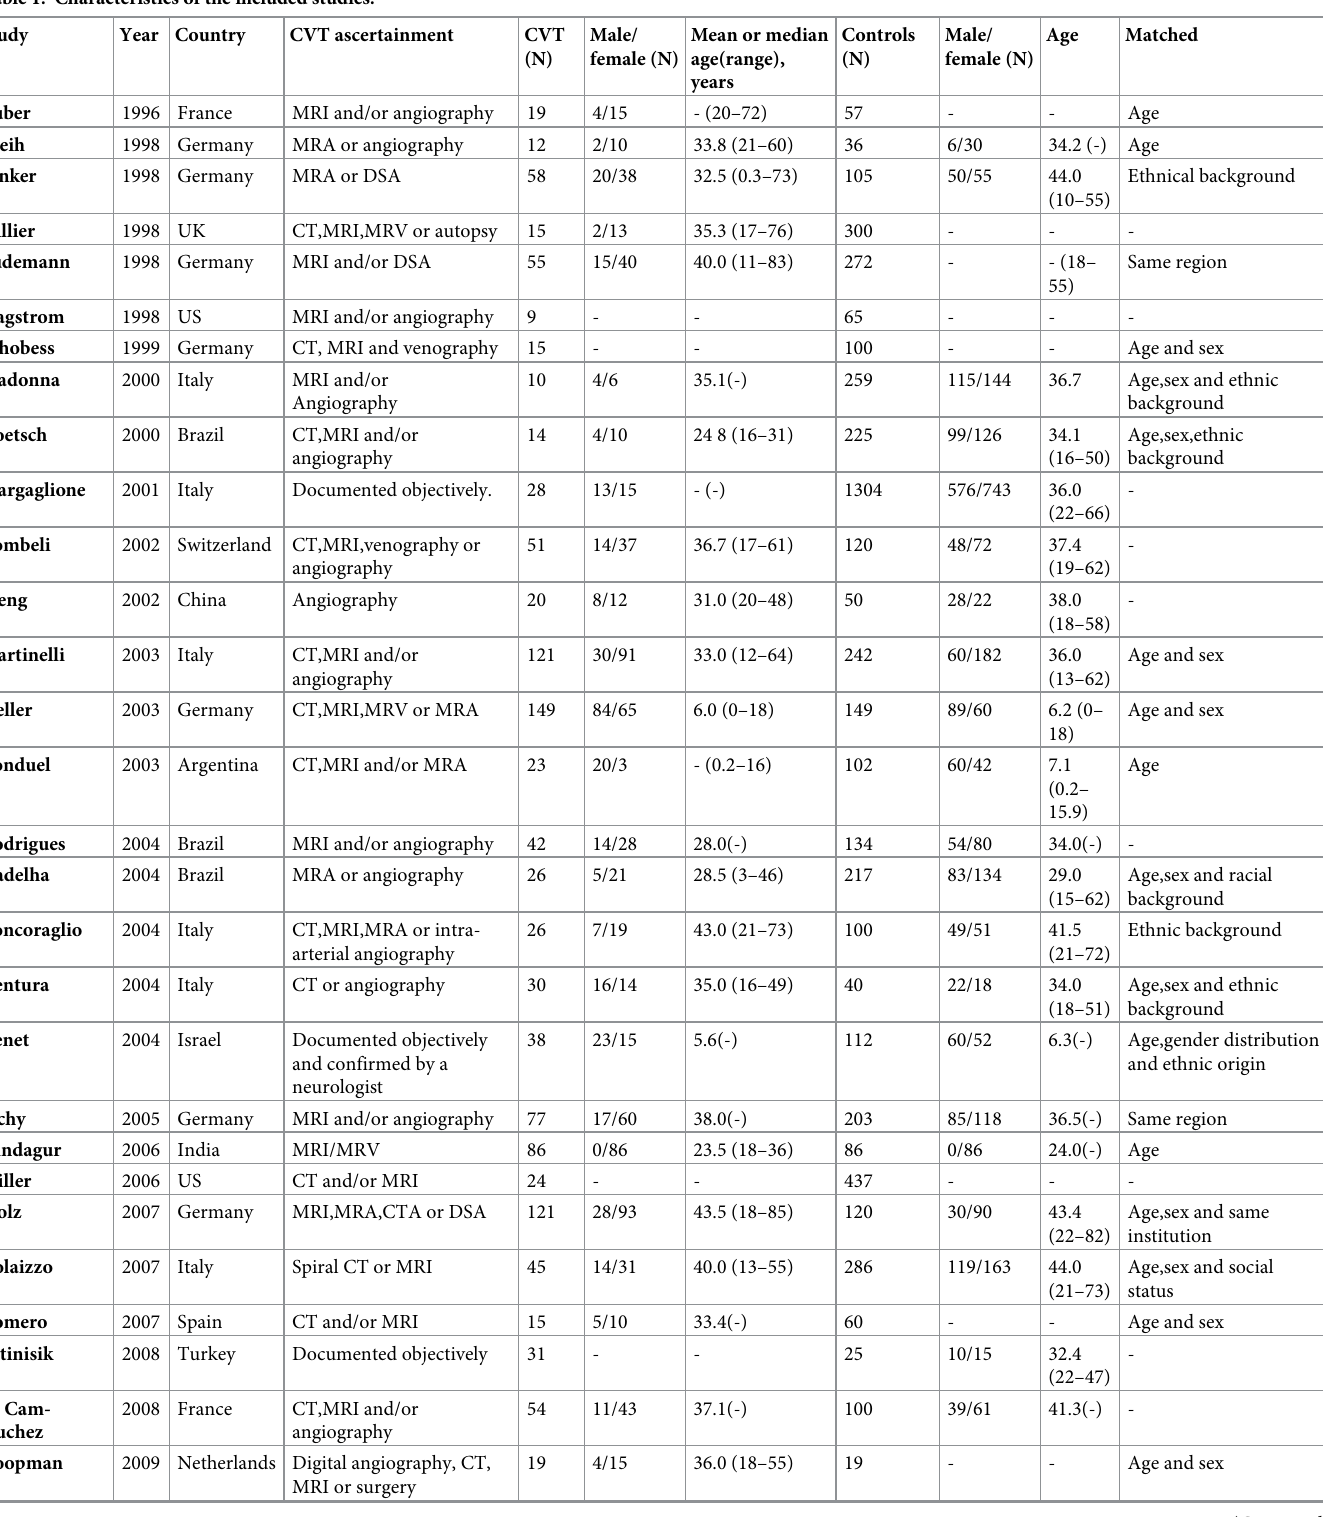
Table 1. Characteristics of the included